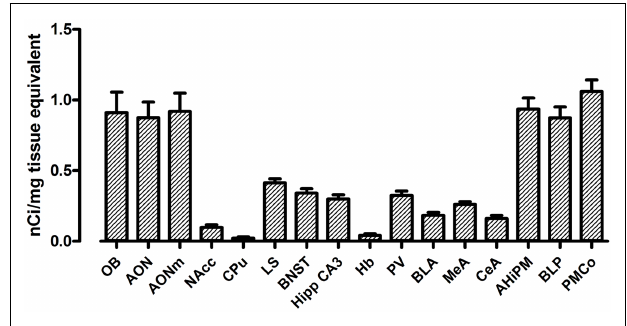
FIGURE 2 | Regional distribution and quantification of OXTR inWT mice . Average regional expression of OXTR defined by [ 125 I]-OVTA binding inWT mice. For each animal, final levels of OXTR expression were calculated averaging data obtained from the different coronal planes analyzed within the same region of interest. Each bar represents data expressed as mean and SEM of four animals.